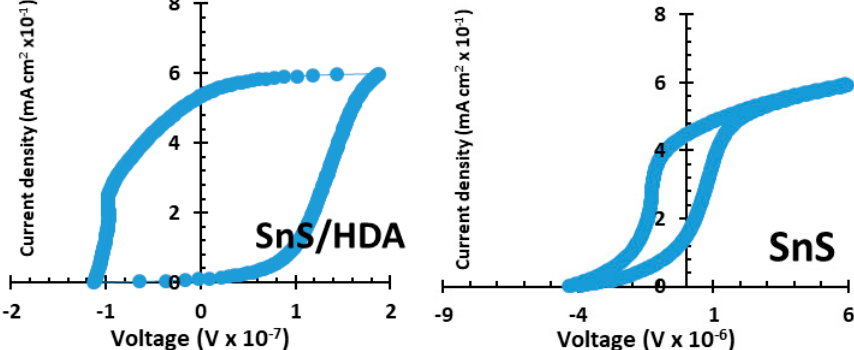
/ HDA and SnS nanoparticles.